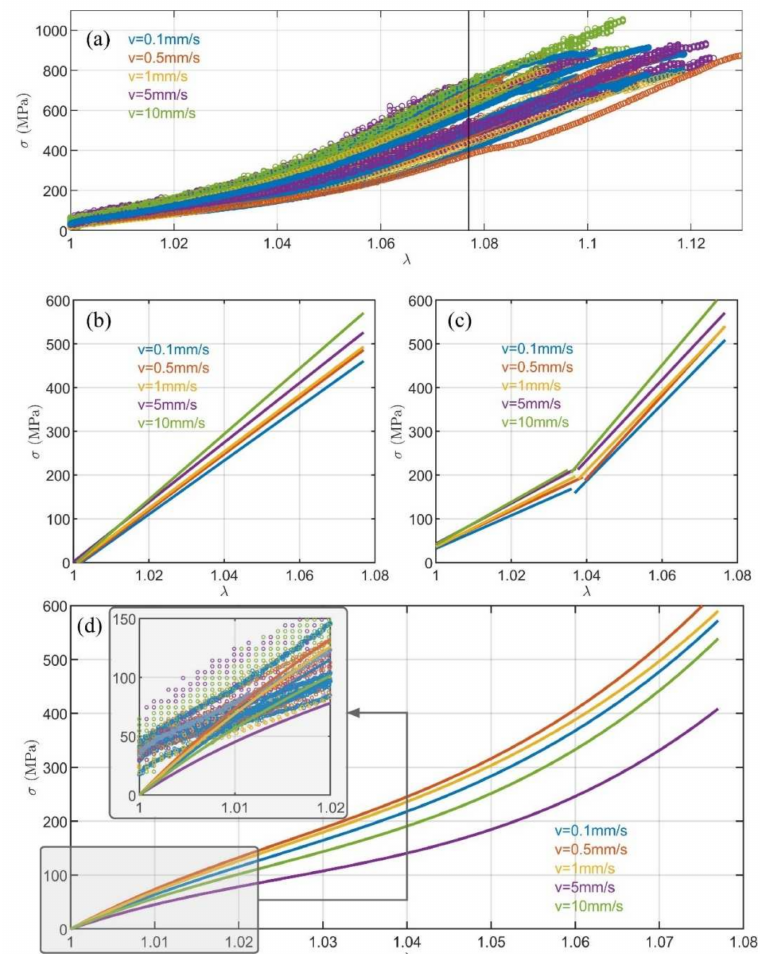
Figure 2. Stress–stretch ratio of the load-to-failure test at 0.1 mm/s, 0.5 mm/s, 1 mm/s, 5 mm/s, and 10 mm/s: ( a ) experimental data points; ( b ) linear fitted models; ( c ) bilinear fitted models; and ( d ) hyperelastic fitted models, with a magnification of interval 1 ≤ λ ≤ 1.02, also showing the markers of the experimental